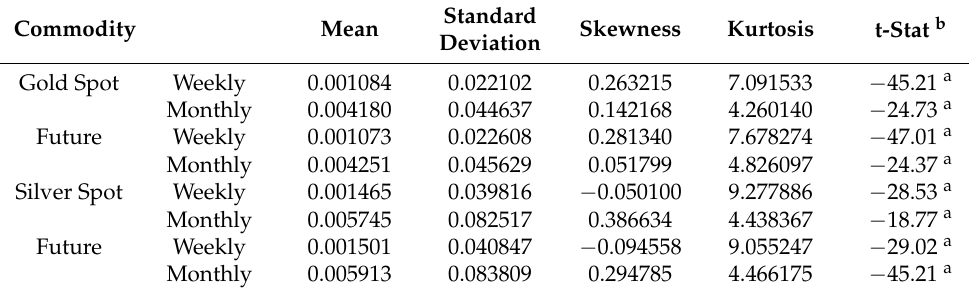
Table 1. Descriptive statistics and unit root test results.